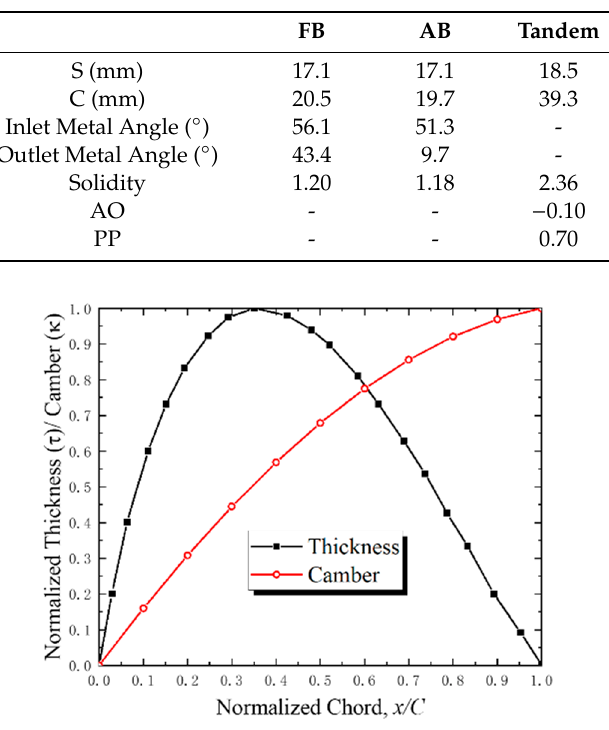
Figure 4. Tandem blade camber line and thickness.